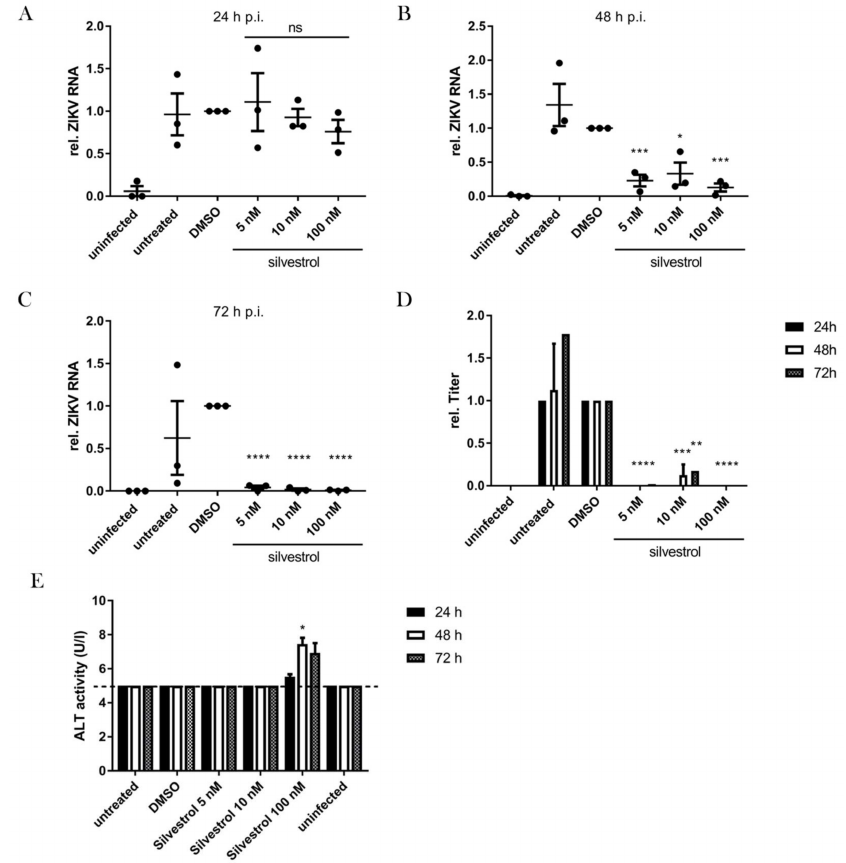
Figure 5. Silvestrol exerts an anti-ZIKV effect also in primary cells. Primary human hepatocytes were infected with ZIKV FP and treated with the indicated concentrations of silvestrol. The extracellular ZIKV RNA was quantified by RT-qPCR after 24 ( A ), 48 ( B ), and 72 h ( C ); ( D ) Extracellular titers of infected and treated primary human hepatocytes (PHHs) after 48 and 72 h. Shown are titers from just one PHH donor quantified by plaque assay in Vero cells; ( E ) ALT activity in PHH supernatants. ns = not significant = p > 0.05; * = p ≤ 0.05; ** = p ≤ 0.01; *** = p ≤ 0.001; **** = p ≤